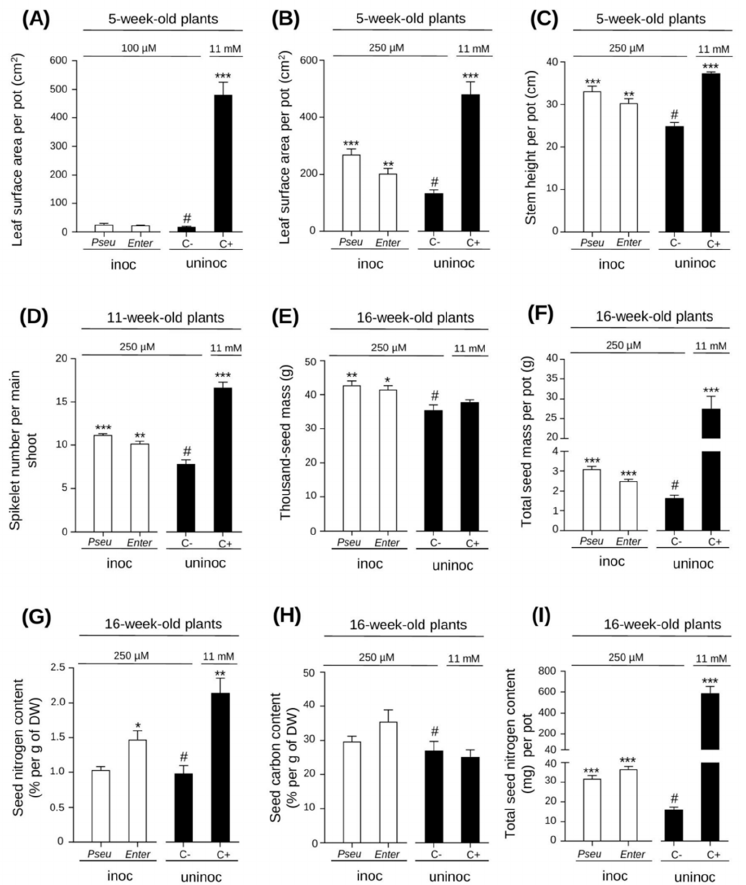
Figure 2. Effect of inoculation with BPMP-PU-28 ( Pseudomonas urmiensis ) and BPMP-EL-40 ( Enterobacter ludwigii ) on plant development under low assimilable nitrogen availability. Elite durum wheat cultivar Anvergur plants were grown in a greenhouse in pots on an artificial solid substrate (6 pots per condition, 4 plants per pot). They were inoculated with one of the two selected strains, BPMP-PU-28 (Pseu: Pseudomonas urmiensis ), BPMP-EL-40 (Enter: Enterobacter ludwigii ), or not inoculated (Uninoc). Nutrients necessary for plant growth were brought with 3 different watering solutions, all derived from Hoagland medium but containing either 100 or 250 µM of assimilable nitrogen (provided as NO 3 ) for inoculated plants (white bars) or non-inoculated “negative” control plants (C-, black bars), or containing 11 mM of assimilable nitrogen (10 mM NO 3 and 1 mM NH 4+ ) for uninoculated “positive” control plants (C+, black bars). Leaf surface area and leaf sheath height were measured by the Phenoarch phenotyping platform. ( A ) and ( B ) Leaf surface area of 5-week-old plants. The plants watered with 100 µM NO 3 ( A ) were chlorotic and died during the following week. The plants watered with 250 µM NO 3 ( B ) developed and produced seeds. ( C ) Leaf sheath height (5-week-old plants). ( D ) Spikelet number per main shoot (11-week-old plants). ( E ) Thousand-seed mass (16-week-old plants). ( F ) Total seed mass per pot. ( G ) Seed nitrogen content (% per g of DW). ( H ) Seed carbon content (% per g of DW). ( I ) Total seed nitrogen content (mg) per pot. ( E – I ): 16-week-old plants. Means ± SE (n = 6 pots). *, **, and *** above the bars indicate that the difference with the uninoculated condition under nitrogen limitation (#, negative control: C-) is statistically significant (Student’s t -Test, p ≤ 0.05, 0.01, 0.001, respectively).